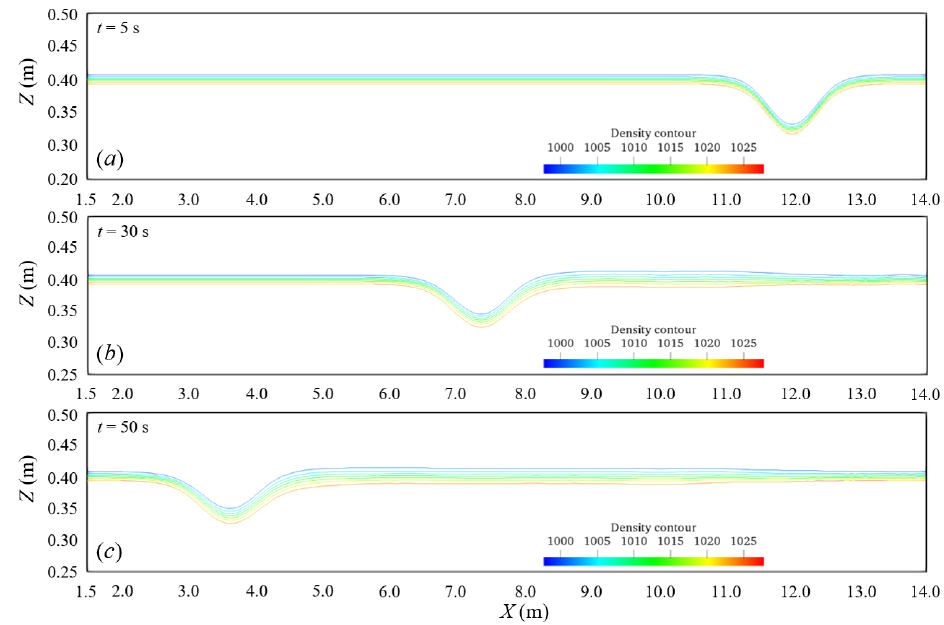
Figure 7. Density contours at different